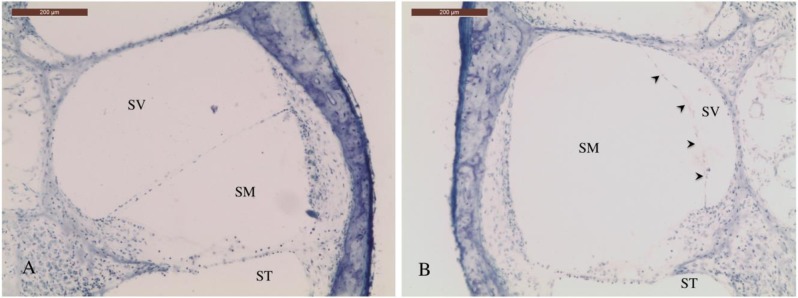
Midmodiolar sections of the cochlea.Second turn of the left (A) and right (B) cochlea from animal #13, under light microscopy and toluidine blue stain. Arrowheads point the dilation of the Reissner’s membrane (B). (SM: scala media, SV: scala vestibuli, ST: scala tympani).